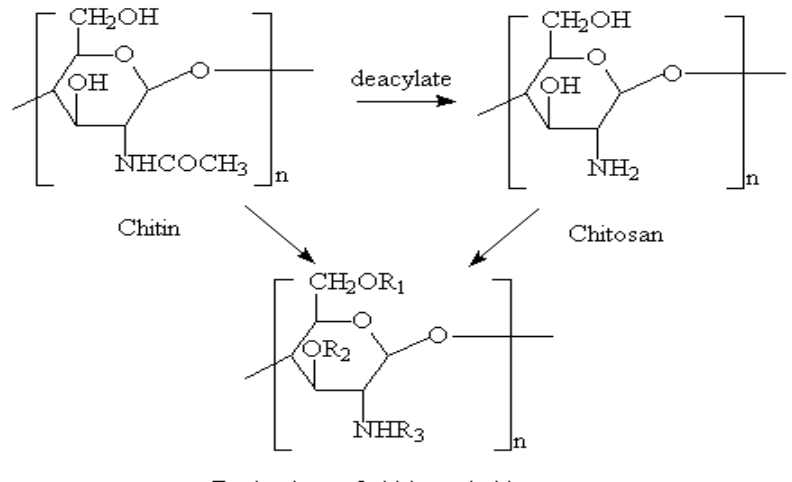
Figure 6. Molecular structure of chitosan [122].